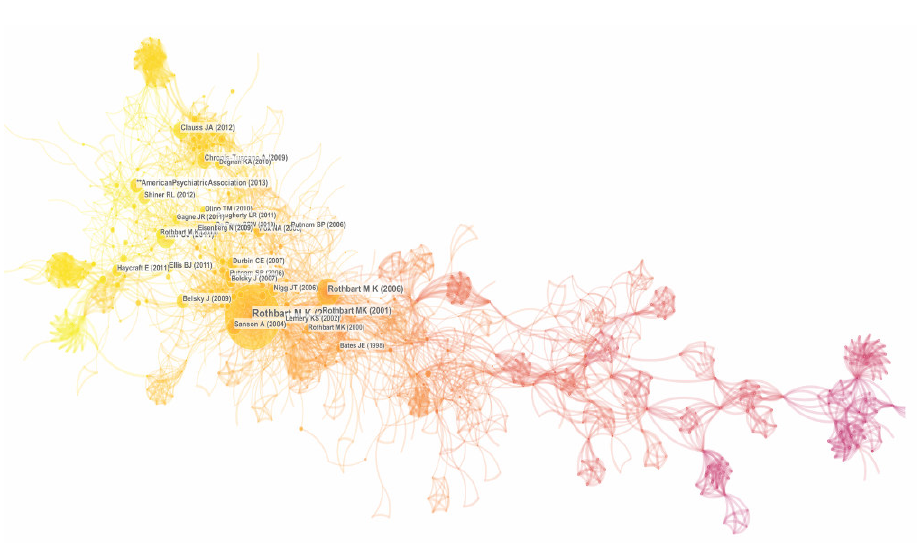
Figure 6. The Network Structure of Citations by Sources